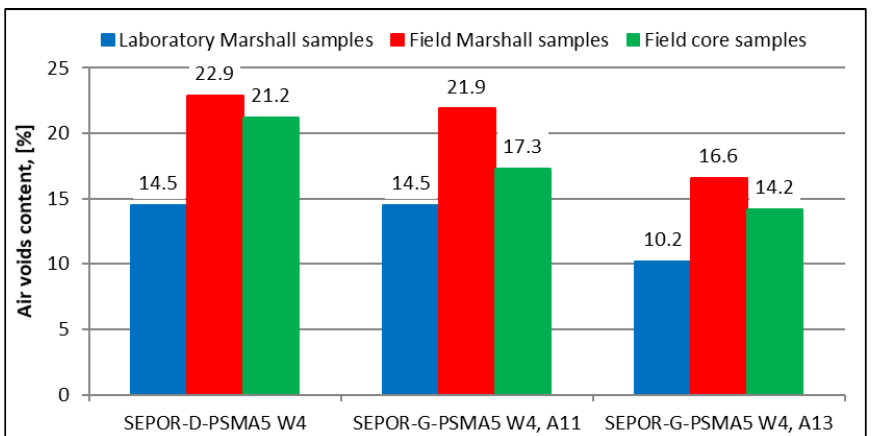
Figure 23. SEPOR-PSMA5 W4 laboratory test results: laboratory and field air voids content comparison.